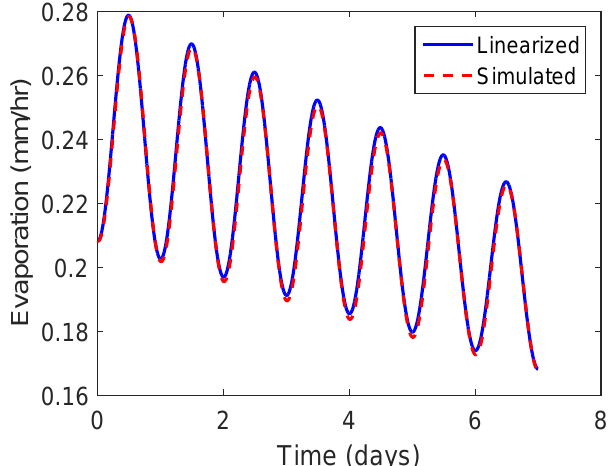
Figure 7. The evaporation pattern obtained from solving system (27) which has been linearized about the average evapotranspiration value and from simulating the nonlinear system in